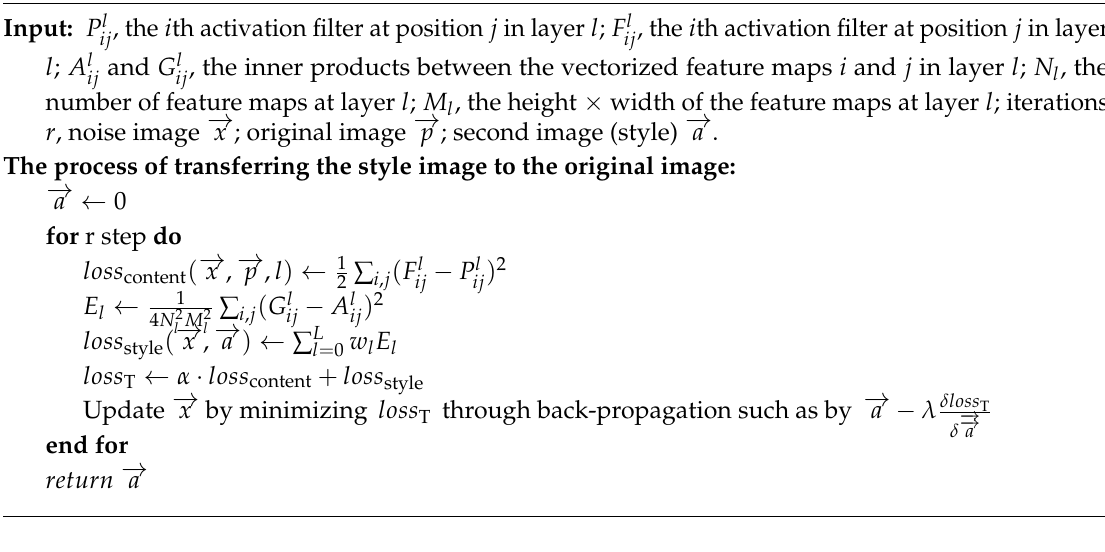
Algorithm 1 Transferring the style image to the original